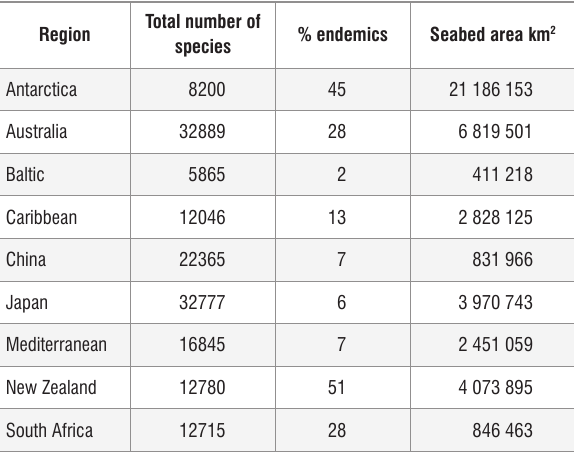
Numbers of marine species reported from various regions globally, the percentage of these that are endemic and size of